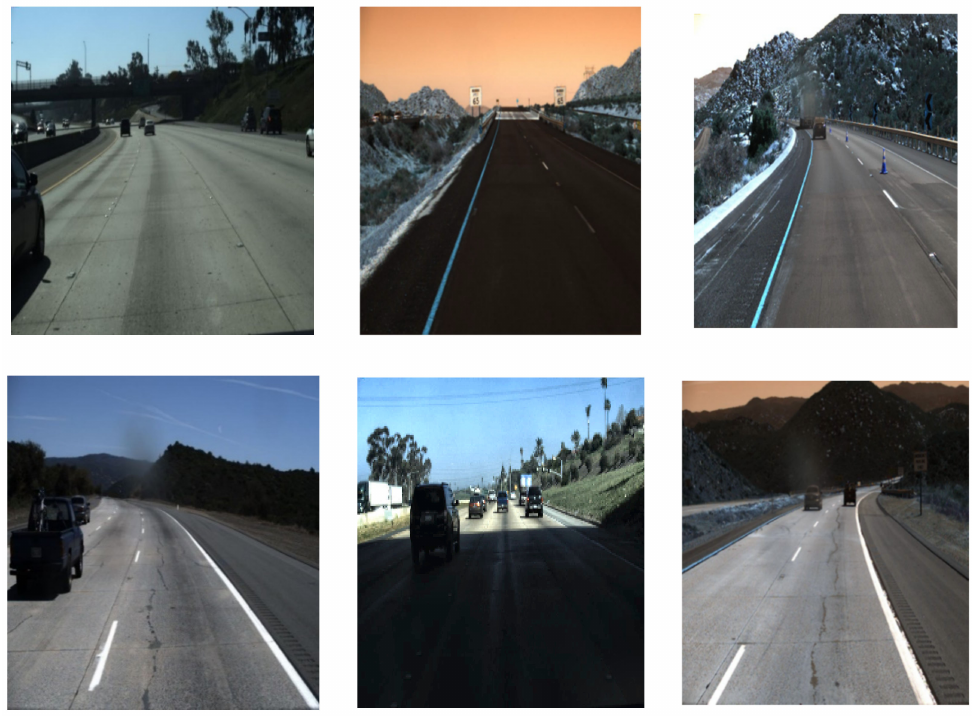
Figure 13. Sample image frames of the Tusimple dataset.